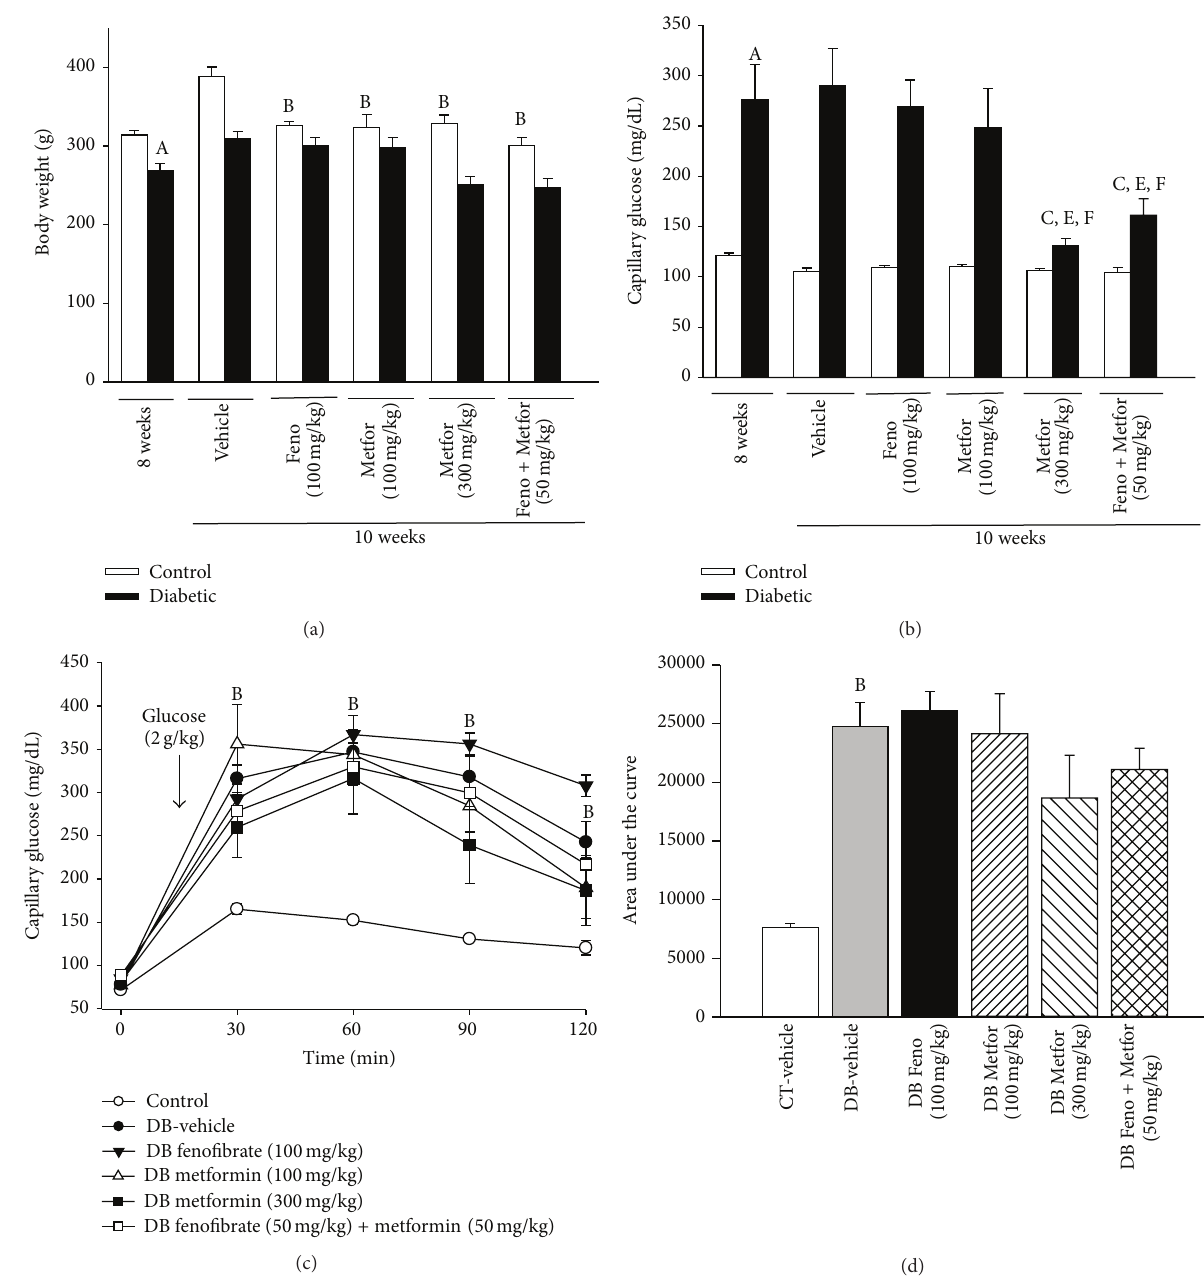
Figure 2: Effect of subchronic treatment (14 days) of different drugs on (a) body weight and (b) nonfasting capillary glucose concentrations of control- (CT-) and diabetic- (DB-) rats. (c) Capillary glucose levels in CT- and DB-rats before and during an oral glucose tolerance test (OGTT) (2g/kg) after 14 days of subchronic treatment. (d) Area under the curve for OGTT. A 𝑃 < 0.05 versus CT, B 𝑃 < 0.05 versus CT-vehicle, C 𝑃 < 0.05 versus DB-vehicle, E 𝑃 < 0.05 versus fenofibrate (Feno, 100 mg/kg), and F 𝑃 < 0.05 versus metformin (Metfor, 100 mg/kg) two-way ANOVA followed by Duncan’s post hoc test. Data are presented as means ± SEM of 6 animals per group.